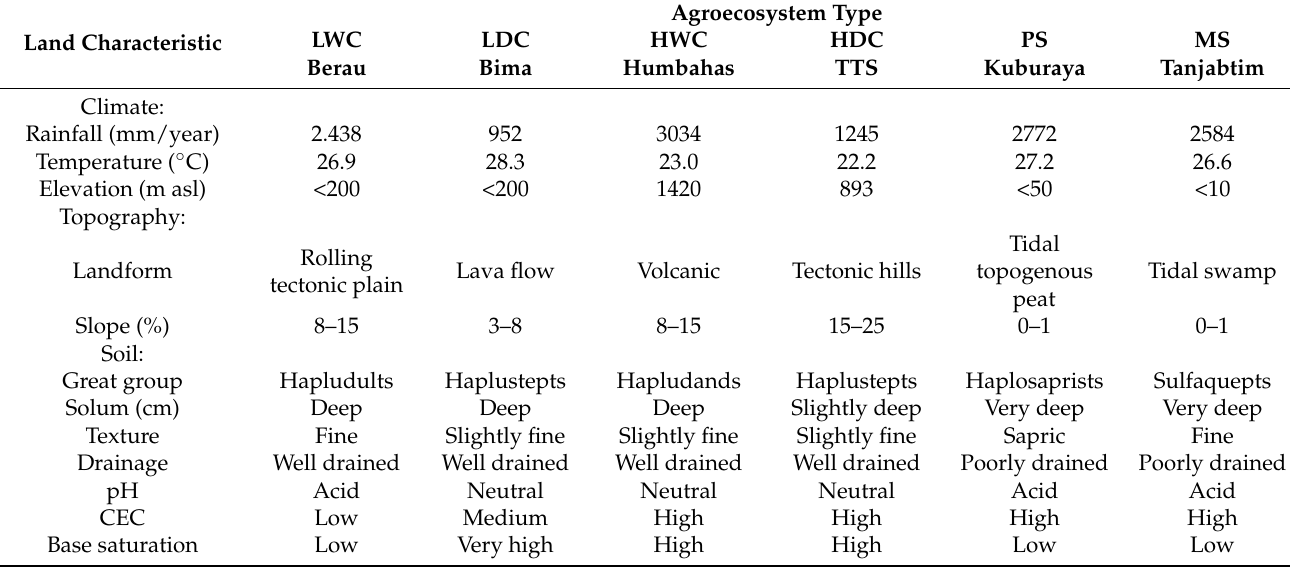
Table 3. Soil and climate characteristics of AL in six agroecosystems.